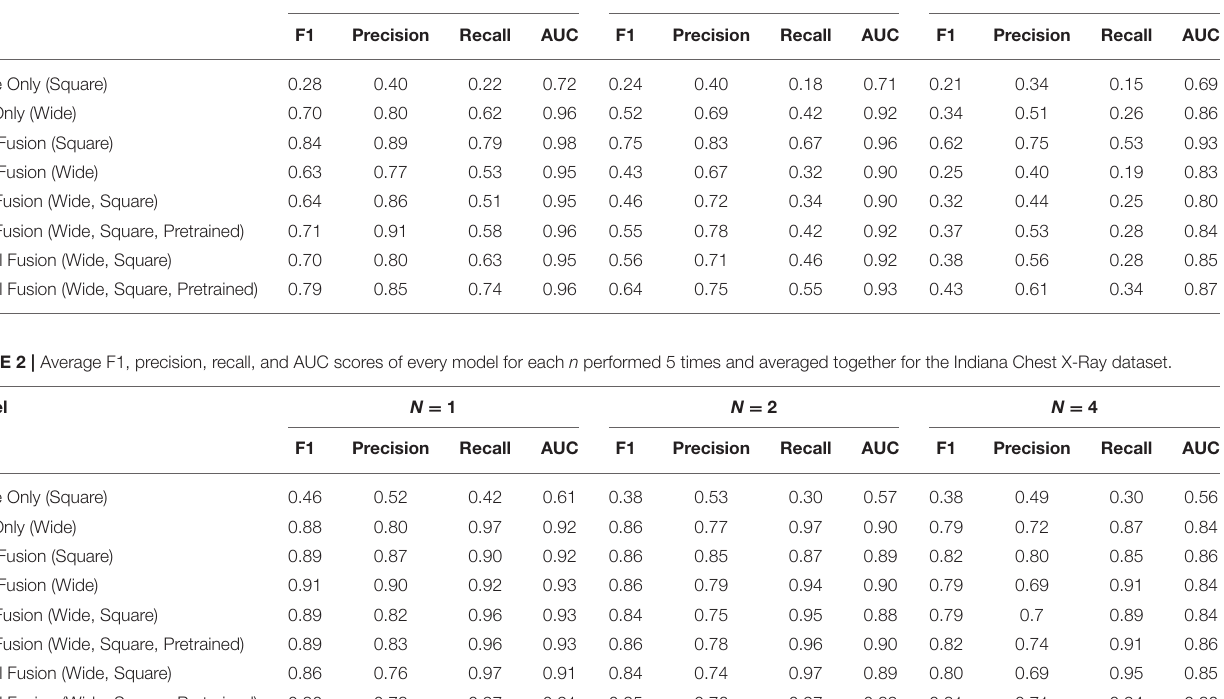
TABLE 1 | Average F1, precision, recall, and AUC scores of every model for each n performed 5 times and averaged together for the PadChest dataset. Model N = 1 N = 2 N = 4 F1 Precision Recall AUC F1 Precision Recall AUC F1 Precision Recall AUC Image Only (Square) Text Only (Wide) Early Fusion (Square)